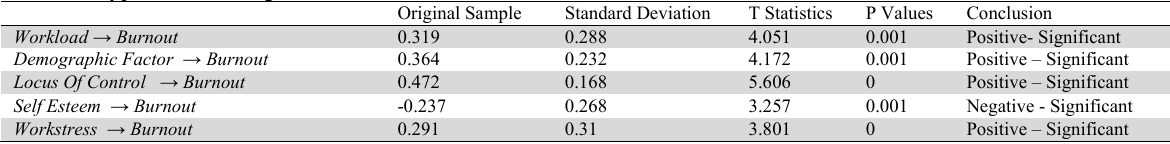
Result of Hypothesis